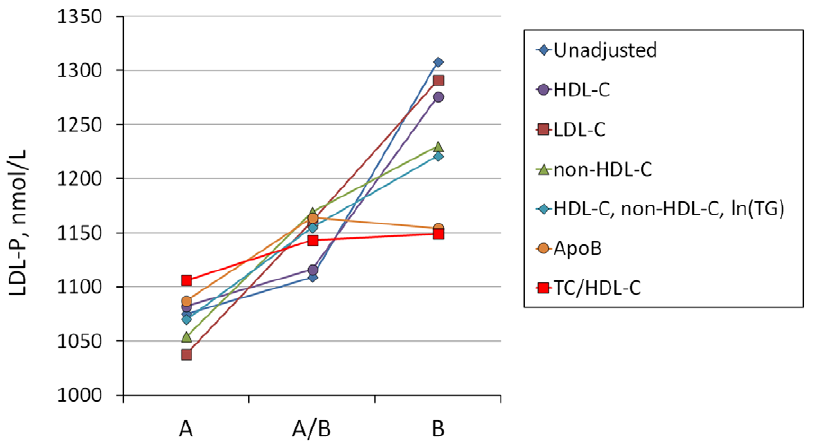
Figure 2. Mean LDL-P vs. LDL density phenotypes with covariate adjustments. Note that the effect of LDL modal density phenotype on LDL-P is rendered insignificant by HDL-C, ApoB and TC/HDL-C ratio.